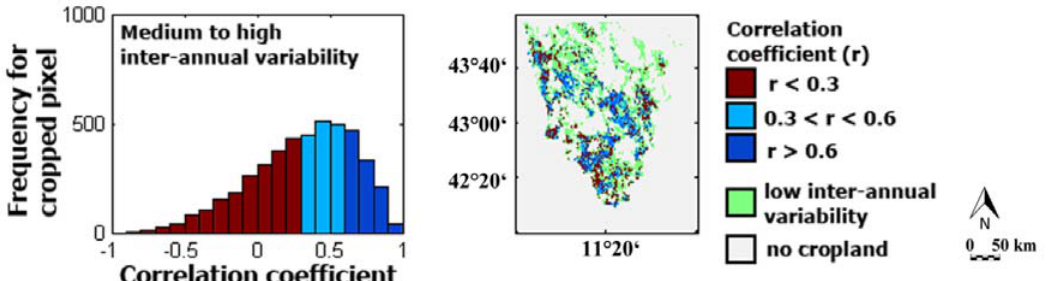
Figure 10. Correlation coefficient (r) between the reference AFIw and the corresponding (cross-validated) estimates (n = 8) at pixel level for AVHRR grid cells having a medium to high inter-annual winter crop area variability. ( left ) Frequency distribution. ( right ) Spatial distribution. Pixels with low inter-annual AFIw variability are shown in green (right) and are not included in the frequency histogram